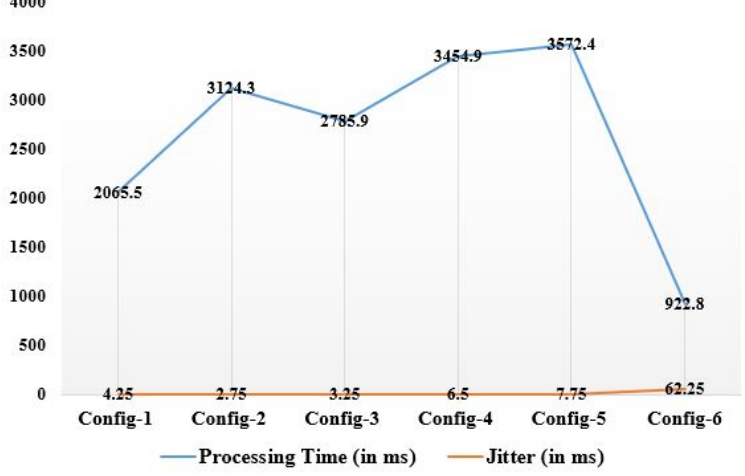
Figure 9. Processing time vs. jitter over various configurations.